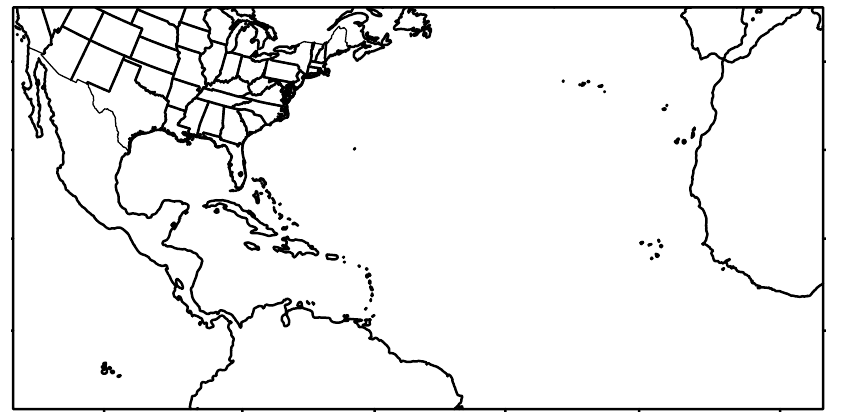
Figure 1. Simulation domain used for the first DD step at 45 km horizontal resolution. It is composed of 240 × 120 grid